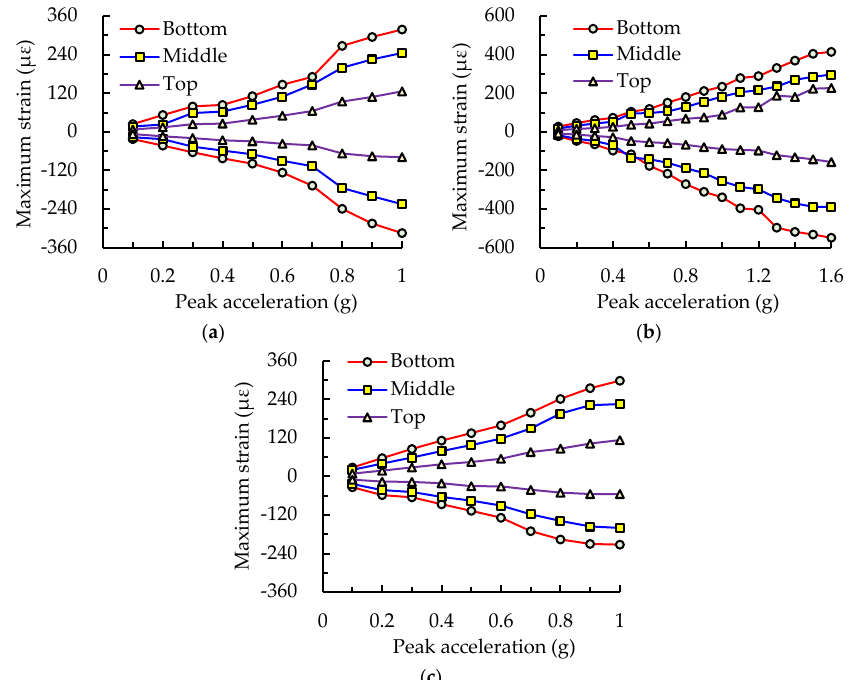
Figure 22. Maximum strains of the frame column subjected to the different intensity levels. ( a ) El Centro wave; ( b ) Kobe wave; ( c ) Taft wave.